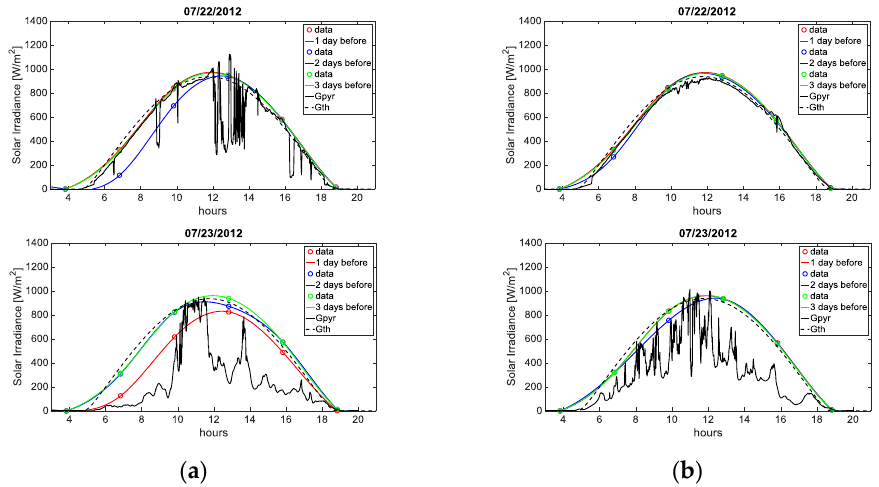
Figure 2. Solar irradiance values from: the Moon-Spencer model ( G th ), pyranometer measurements ( G pyr ), the 3-hour forecasts (dots) and the spline-approximated estimations for seven days of July 2012. ( a ) Site “Gi”; ( b ) Site “Ma”.